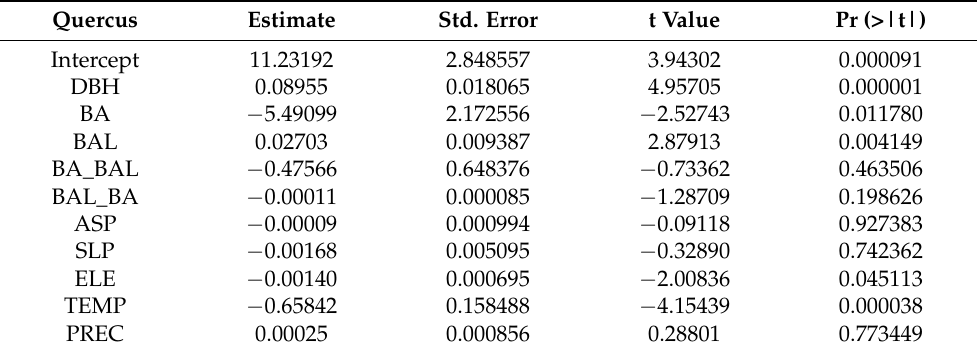
Table 3. Results of the linear mixed-effect model for Quercus diameter